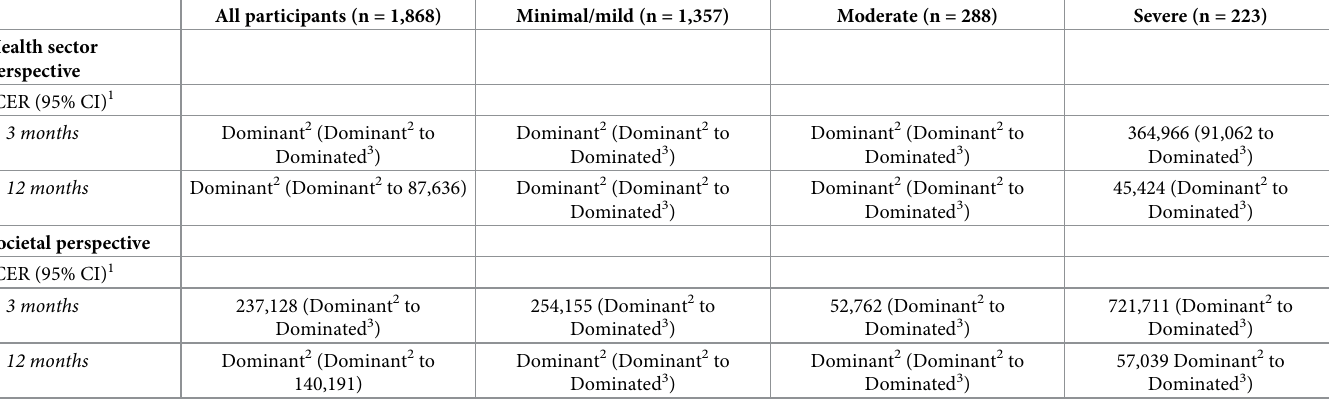
Table 4. Incremental cost-effectiveness ratios under the health sector and societal perspectives, across all participants and stratified by prognostic group. All participants (n =